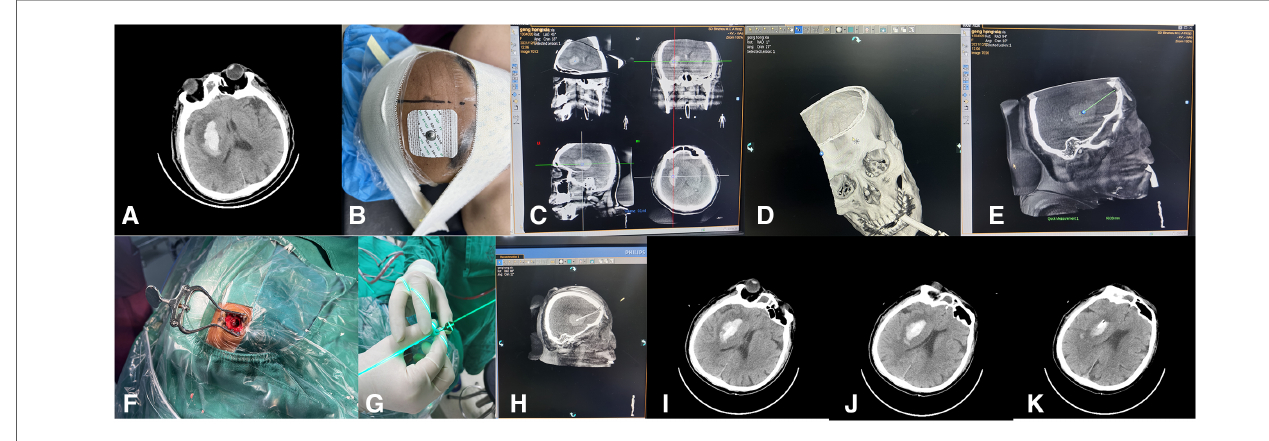
FIGURE 1 The surgical procedure of laser navigation puncture and drainage to treat basal ganglia